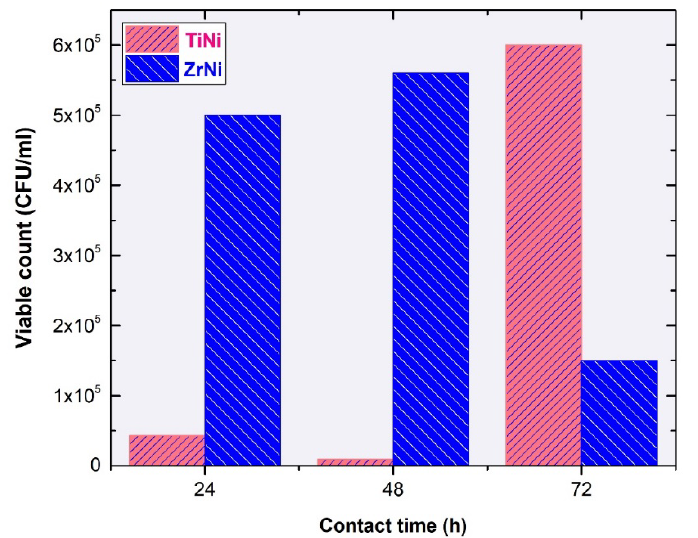
Figure 9. Inhibition of biofilm adhesion by E. coli (ATCC 25922) on binary Ti 50 Ni 50 and Zr 50 Ni 50 sys- tems.